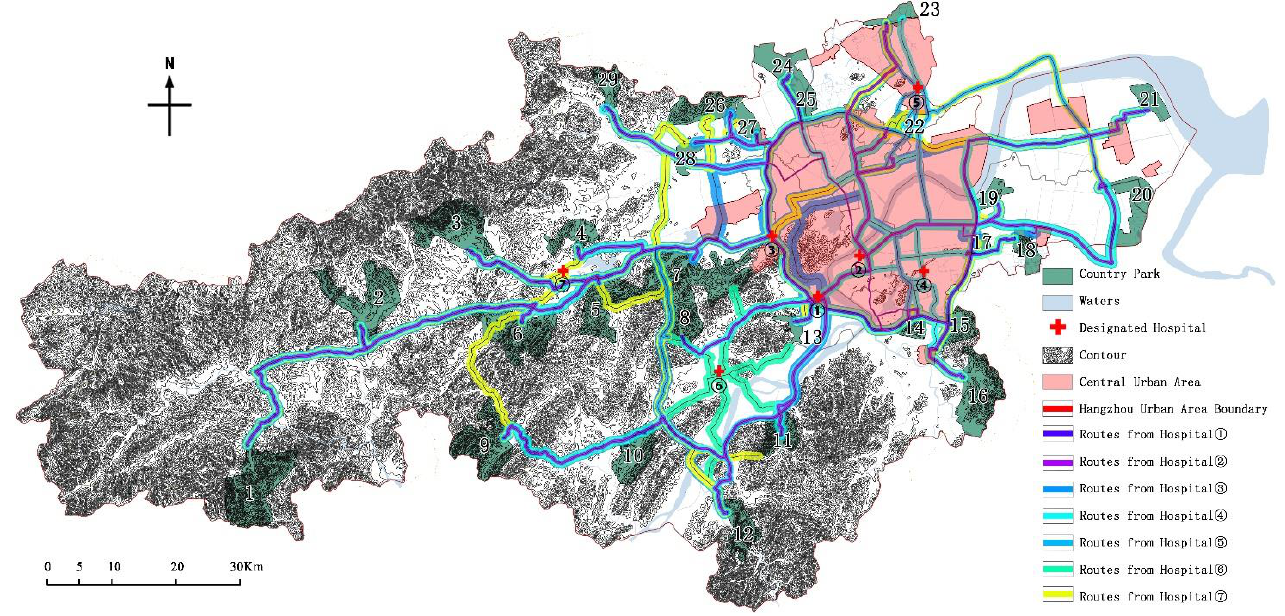
Figure 11. The traffic routes of the country parks to designated hospital.